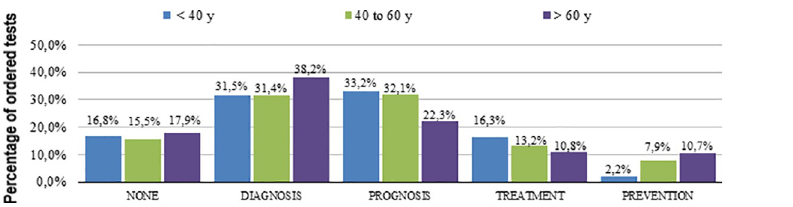
Fig 3. Tests usefulness according to patients’ age. CCI: Charlson index.